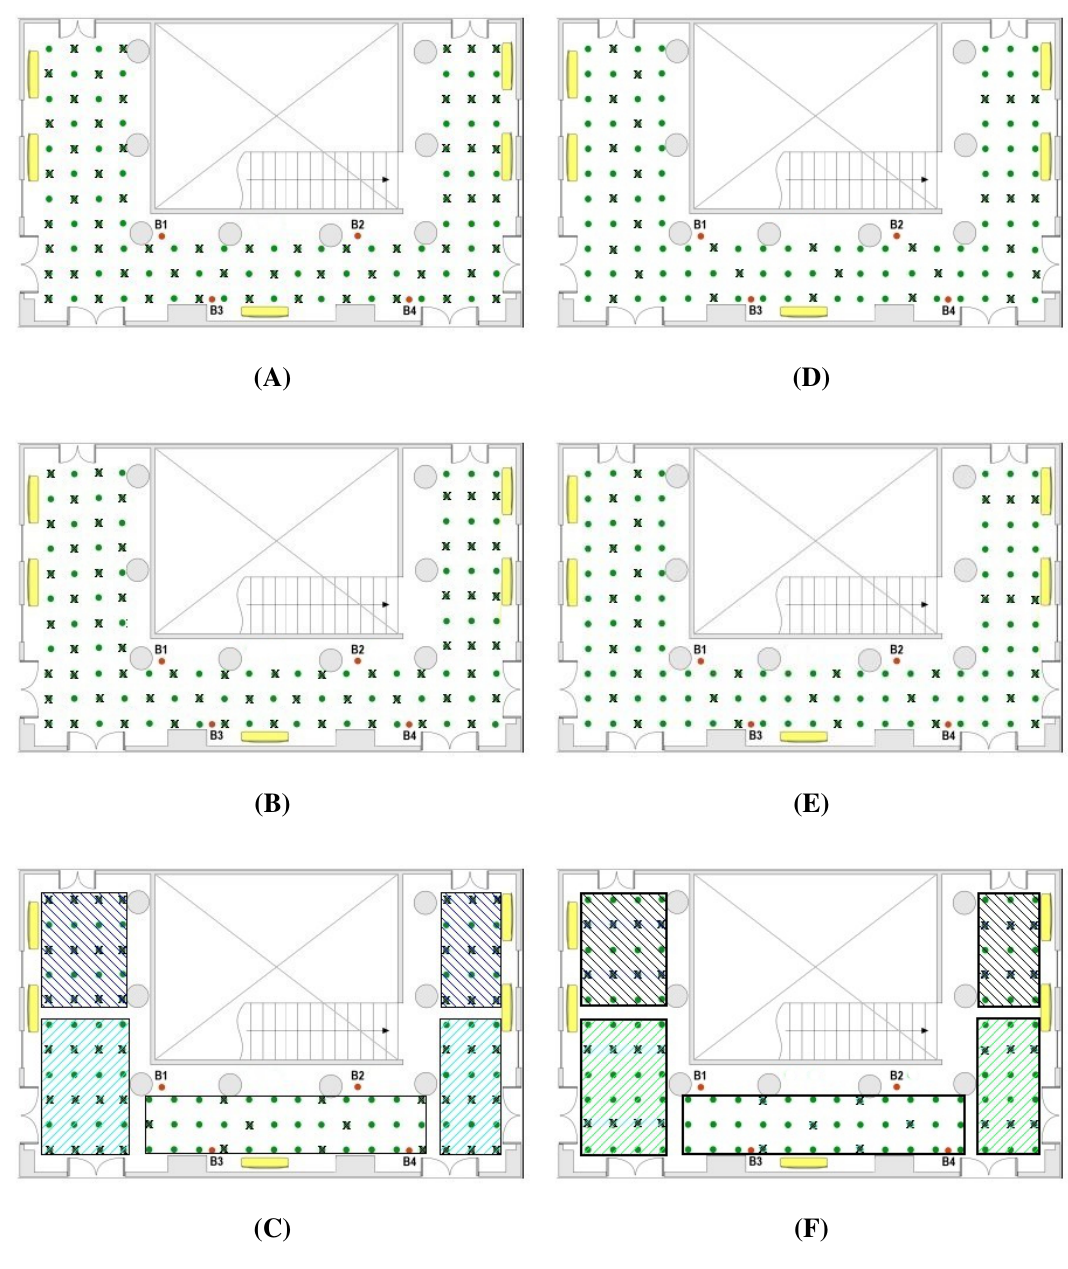
Figure 2. Map of the testing scenario with: ( left) 50% of reference points for three different distributions: ( A ) Uniform; ( B ) Uniform with the complementary points of case A; ( C ) Non-uniform by zones; and (right) 25% of reference points for other three distributions: ( D ) Uniform; ( E ) Uniform with alternative points of case D; ( F ) Non-uniform by zones. The “ × ” denotes the reference points, whereas the green dots are the interpolated